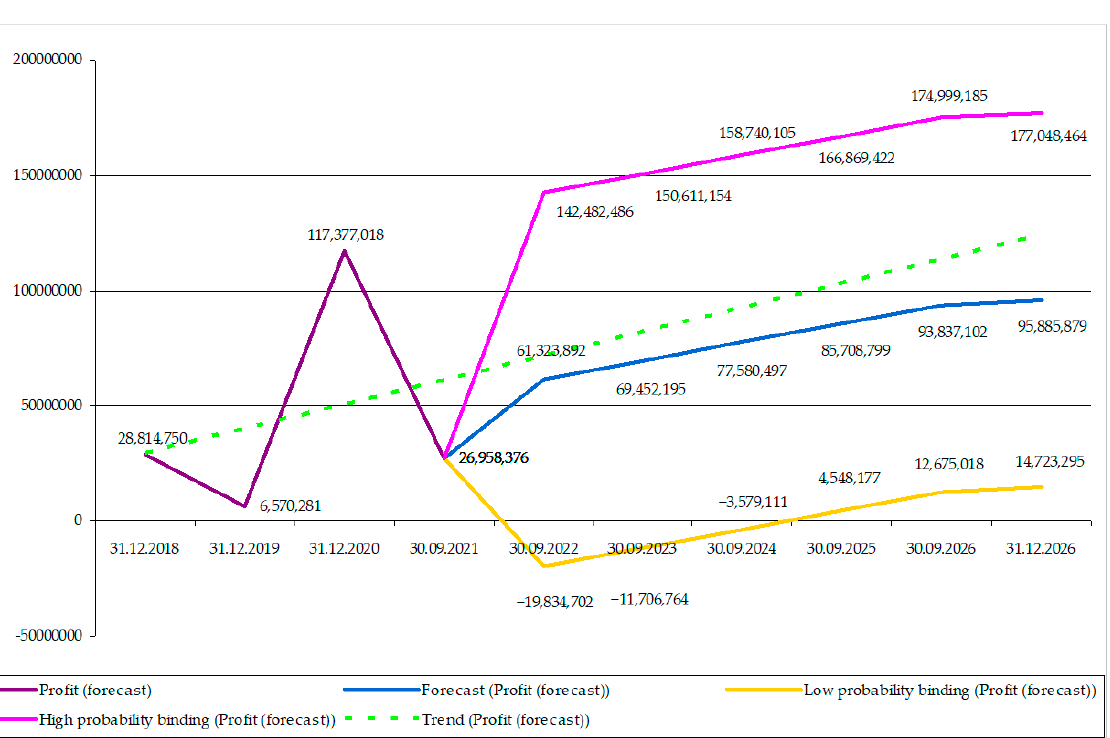
Figure 1. Bank profit trend (author’s research). Thus, one can see that the bank profit increased by $3.6 mln, providing a slight re- distribution of assets and liabilities of the bank. In the business world, change is the only constant. Banks managing change suc- cessfully and efficiently operate successfully, constantly adapting their services, strate- gies, systems, and culture to overcome and take advantage of circumstances that may